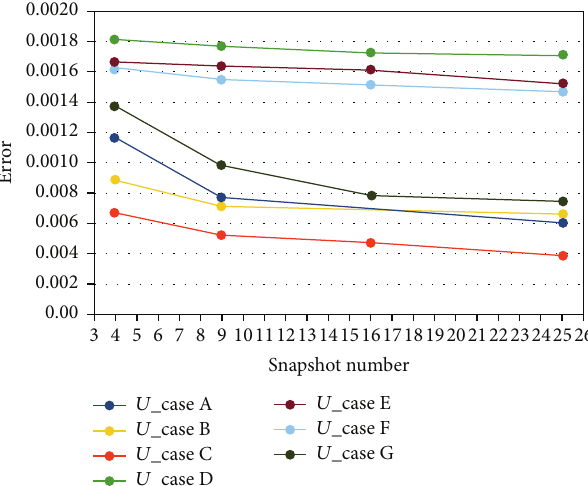
Figure 14: NACA 0012 airfoil. Errors generated by the PODI surrogate model for the reconstruction of the velocity field.